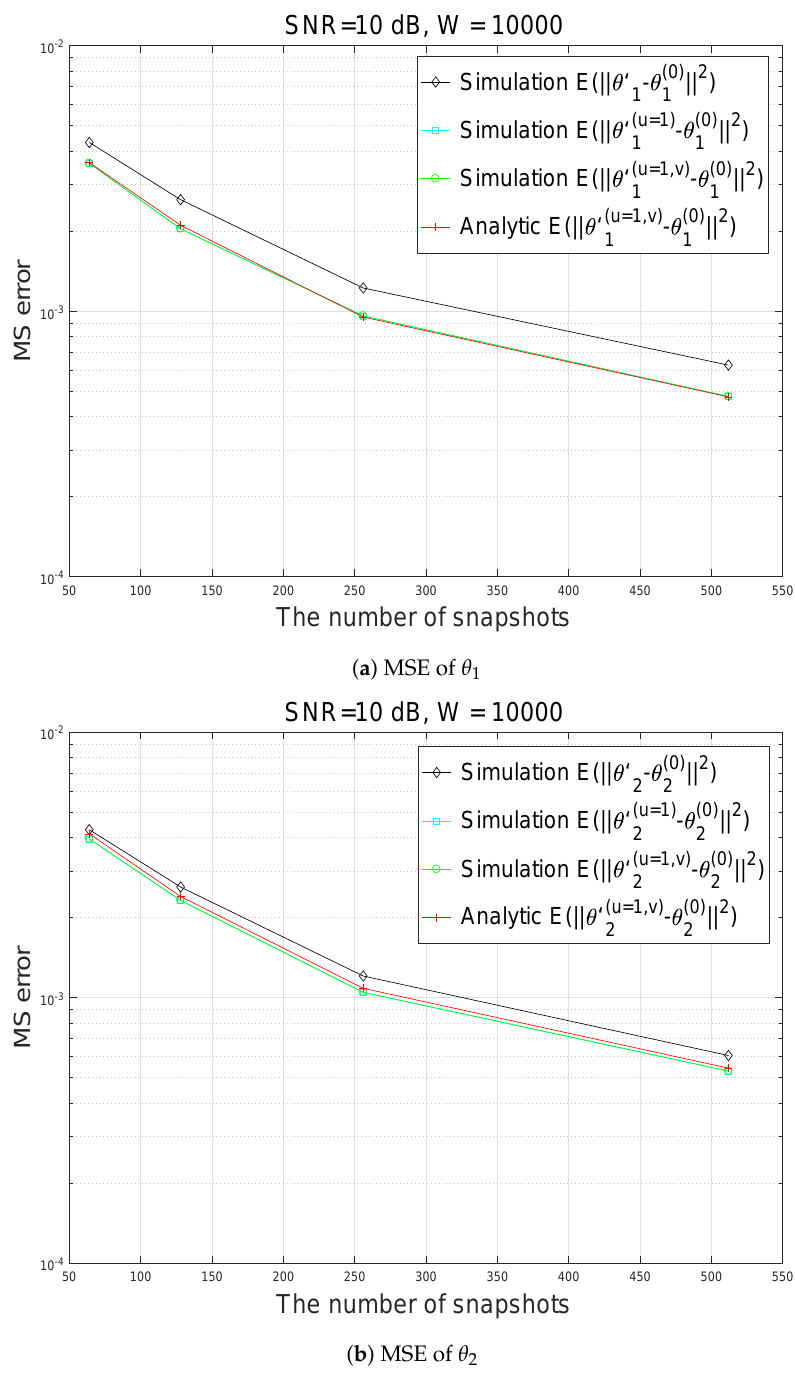
Figure 4. Analytic and simulated MSEs θ 1 and θ 2 with respect to the number of snapshots (SNR = 10 dB). Similarly, the results with ‘Simulation E (cid:20)(cid:16) (cid:17) 2 (cid:21) ˆ θ ( u = 1, v ) − θ ( 0 ) ‘Simulation E ’, and ‘Analytic E 2 2 (44) and (36),